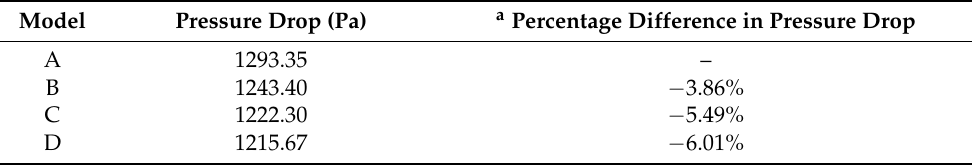
Table 10. Values and percent change of pressure drop for cyclone models A, B, C, and